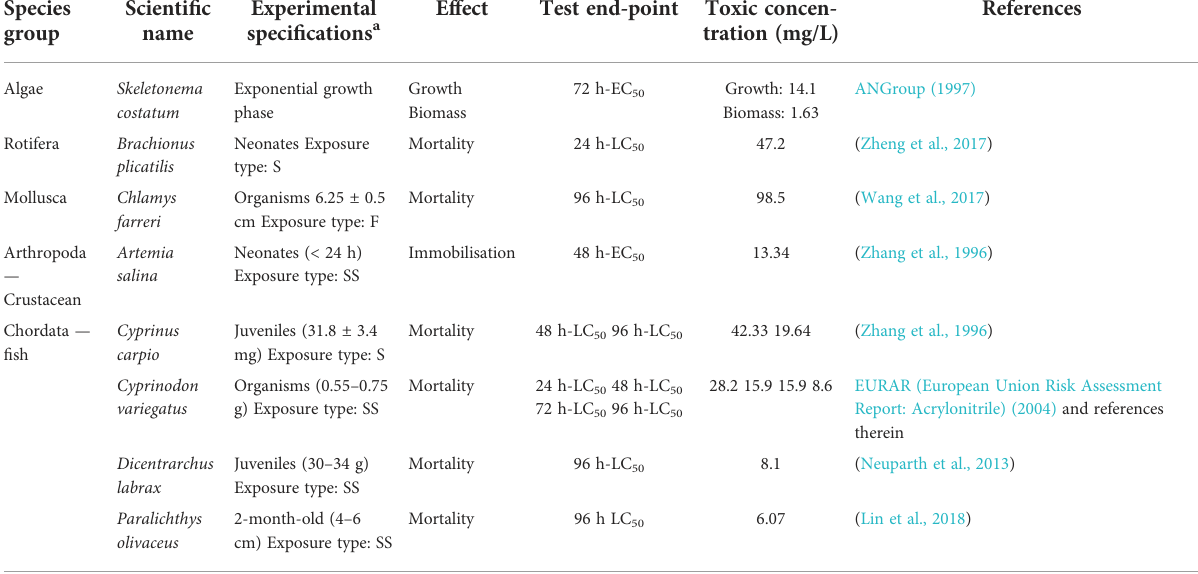
TABLE 2 Toxicological end-points for marine organisms exposed to acrylonitrile. (Supplement from Rocha et al., 2016).